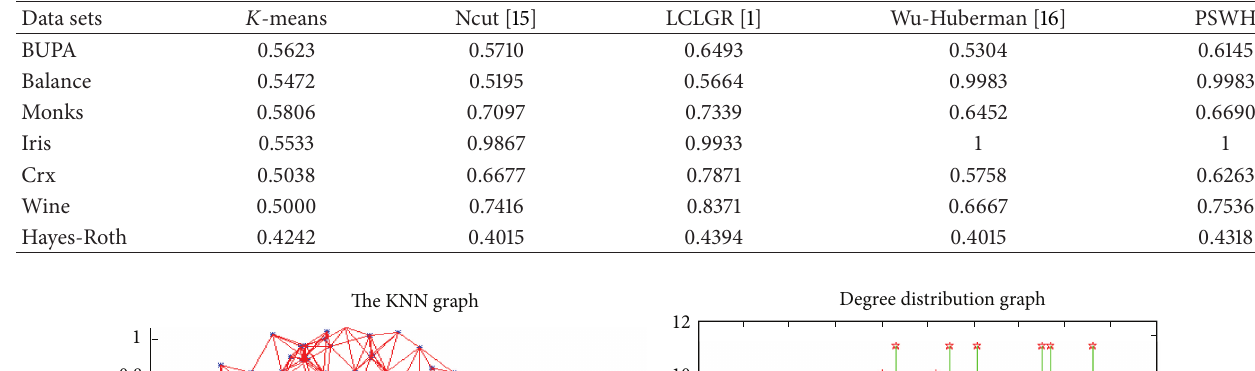
Table 1: Comparison with other algorithms on the clustering accuracy.